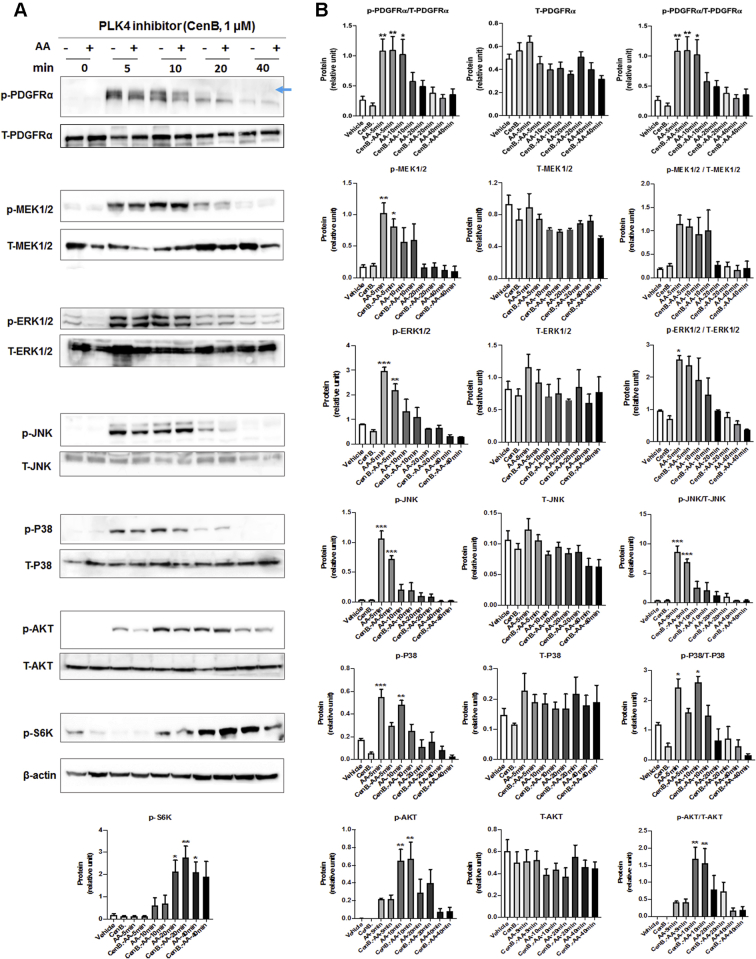
Effect of PLK4 Inhibition on Phosphorylation of PDGFR Downstream KinasesRat primary adventitial fibroblasts were cultured, starved, and pretreated with vehicle (DMSO) or PLK4-selective inhibitor CenB (1 μmol/l, 30 min), and then stimulated with solvent or AA (60 ng/ml) before harvest for Western blotting. The arrow points to the bands of phospho-PDGFRα that were sensitive to AA stimulation. (A) Representative Western blots showing the time course of AA-induced phosphorylation of kinases. p- = phospho-protein; T- = total protein. (B) Quantification: mean ± SEM, n ≥3 experiments, 1-way ANOVA/Bonferroni test: ∗p < 0.05; ∗∗p < 0.01; ∗∗∗p < 0.001 compared with the basal control (vehicle, no AA stimulation, the first bar in each plot). Abbreviations as in Figures 1 and 4.